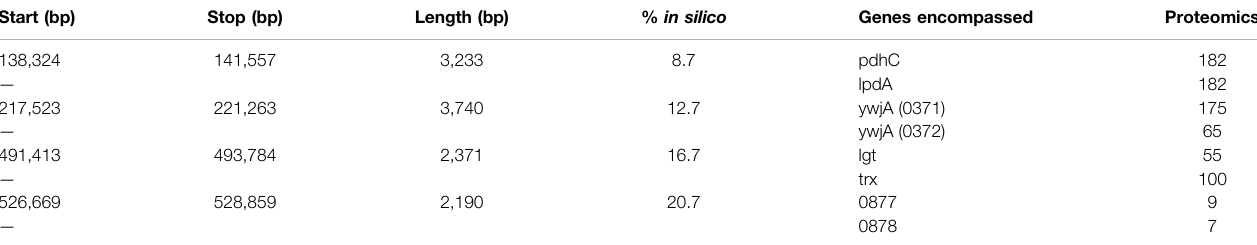
TABLE 2 | Loops inferred from 3C-Seq library of Syn3A. The gene annotations and locus tags are those in the NCBI entry for Syn3A ’ s genome (https://www.ncbi.nlm.nih. gov/nuccore/CP016816.2) and the locus tags are abbreviated to only the 4-digit number. Start (bp) Stop